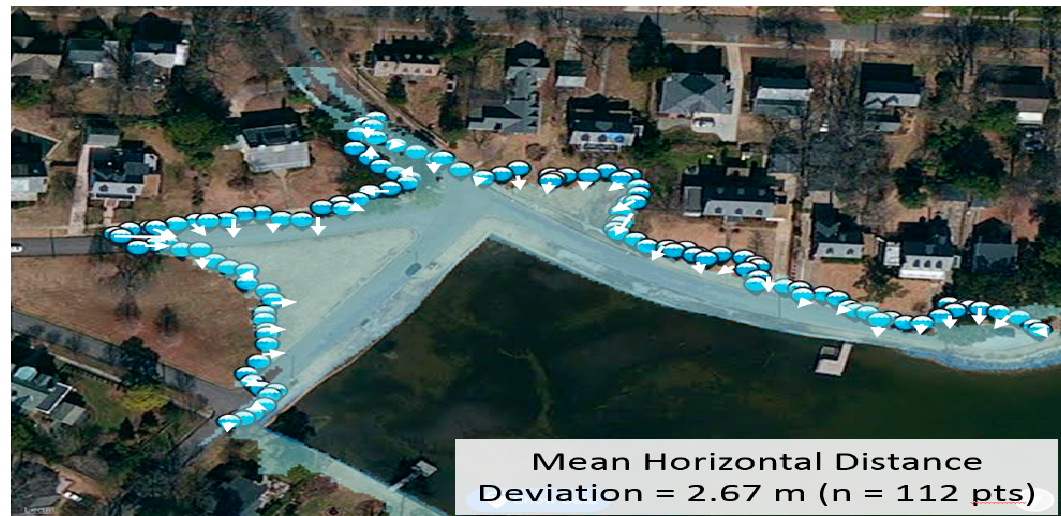
Figure 7. Illustrative comparison of mean distance difference of 112 GPS data points collected in Larchmont, Norfolk (2.67 m), compared with the 2018 king tide peak inundation forecast in blue.